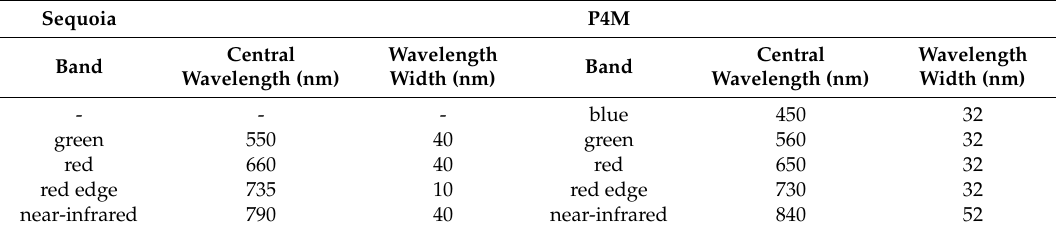
Table 1. SpectralbandinformationfortheParrotSequoia(Sequoia)andDJIPhantom4Multispectral(P4M). Their approximately equivalent bands (green, red, red edge, and near-infrared) were compared in this study.